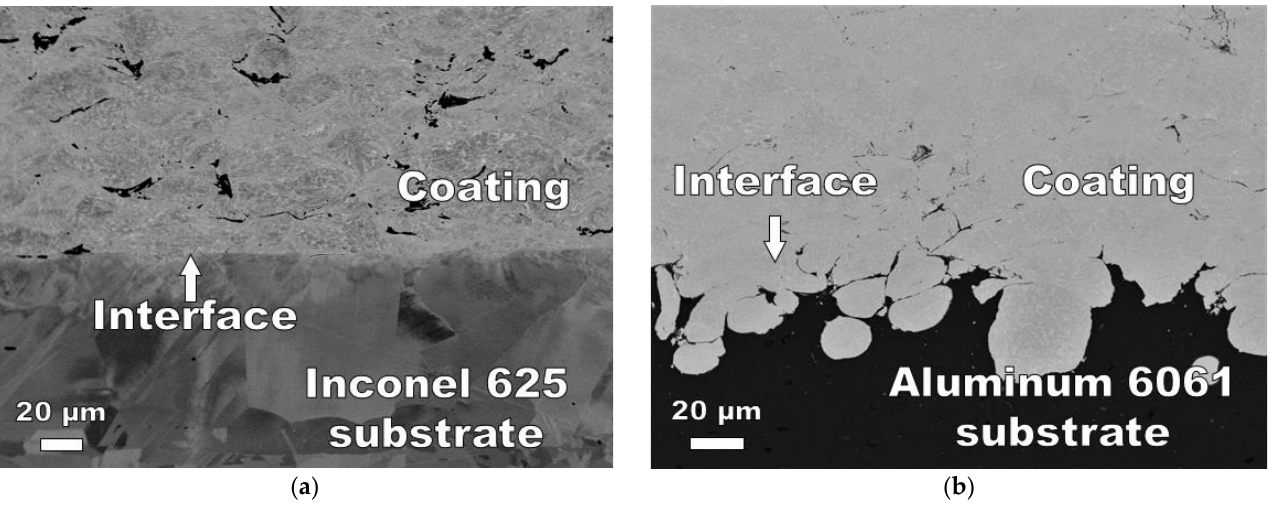
Figure 8. SEM micrograph operated in BSE scanning mode of cold sprayed Inconel 625 coating on ( a ) Inconel 625 and ( b ) Aluminum 6061 substrate. Different interface deformation patterns were observed with different types of substrate material.